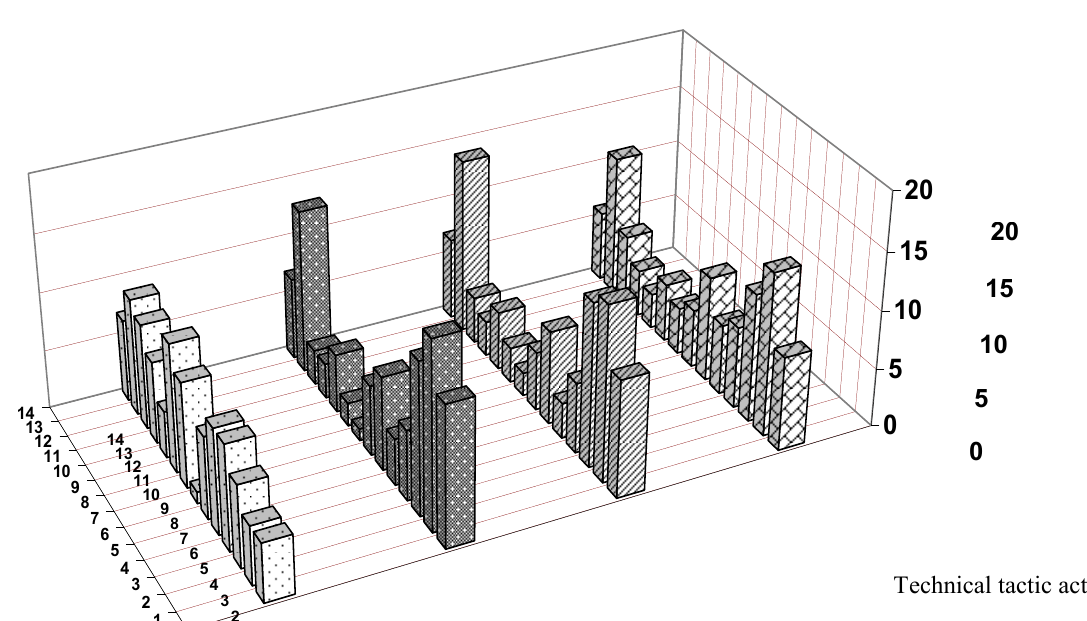
Fig.2. Significance of technical-tactic actions for highly qualified hockey players of different roles (in experts’ opinion,